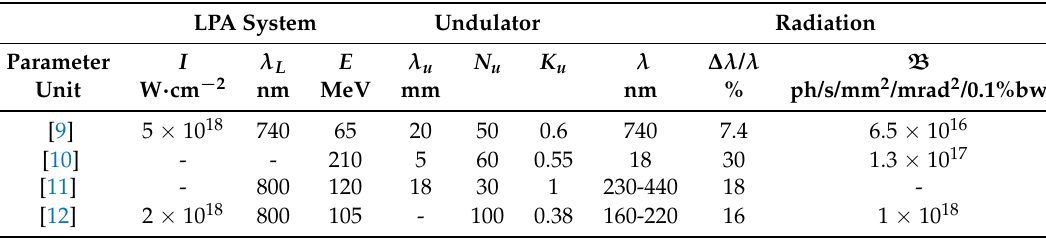
Table 1. Laser and undulator characteristics used for the experiment, alongside the radiation quality produced. I the laser intensity, λ L the laser wavelength, E energy of the produced electron, λ u the undulator period, N u undulator number of periods, K u the deflection parameter, λ the undulator radiation wavelength, ∆ λ / λ the relative bandwidth, B the radiation brilliance.